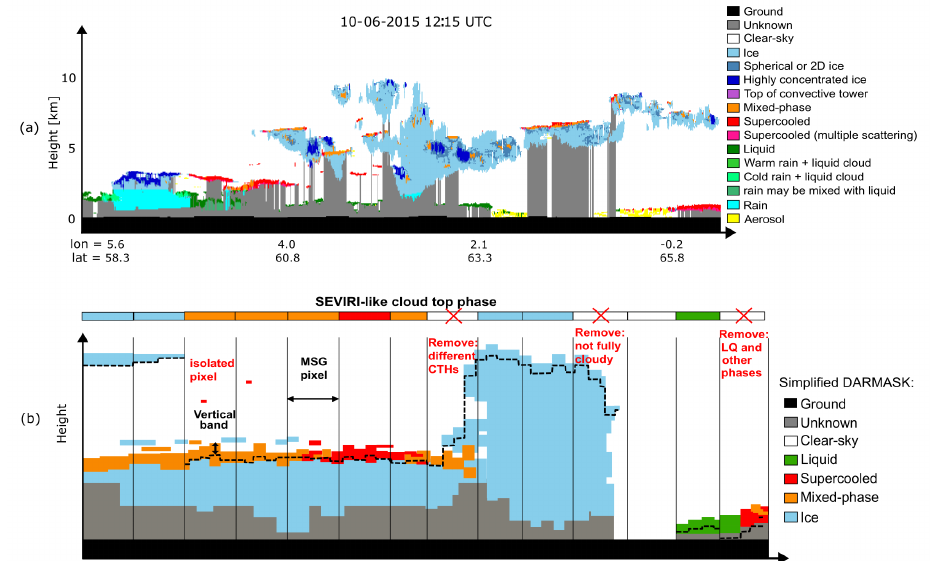
Figure 1. ( a ) Example of the DARDAR-MASK Simplified Categorization variable of the DARDAR- MASK product for an A-Train curtain on 10 June 2015 at 12:15 UTC. The scene shows a cross-section through a stationary occlusion front located just west of Norway. ( b ) Scheme of the SEVIRI-like cloud top phase (CTP) definition. Background: Synthetic two-dimensional DARDAR-MASK scene with phase categories simplified to ice, mixed-phase, supercooled, and liquid. Black vertical lines indicate collocated SEVIRI pixels. All DARDAR values in the vertical band (black dashed line) are considered for the averaging step in coarsening to a CTP in SEVIRI resolution. Isolated cloud gates in DARDAR-MASK are removed before the coarsening. SEVIRI pixels that do not have similar cloud top heights (CTHs) in all DARDAR gates are removed. The resulting SEVIRI-like CTP is shown in color code in the top bar of the